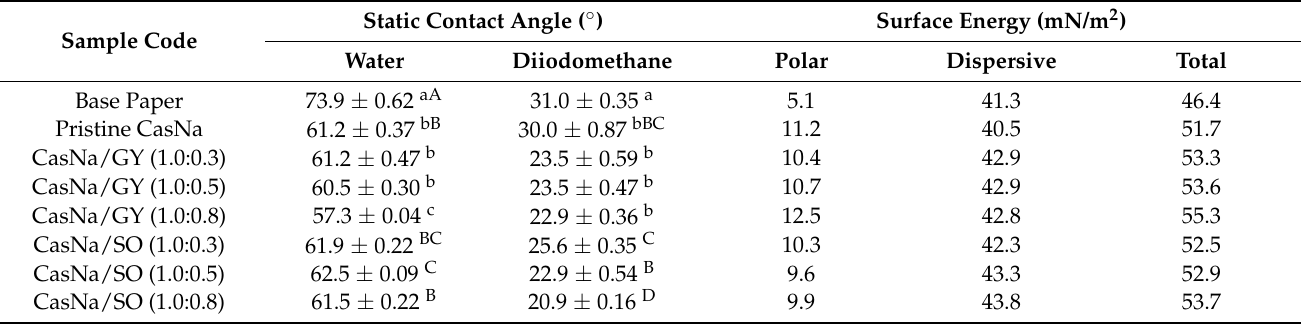
Table 2. Contact angles and surface energy of ( a ) CasNa/GY–coated papers and ( b ) CasNa/SO– coated papers. Lowercase ( a–c ) and uppercase letters ( A–D ) indicate statistically significant differences of CasNa/GY–coated papers and CasNa/SO–coated papers, respectively ( p <